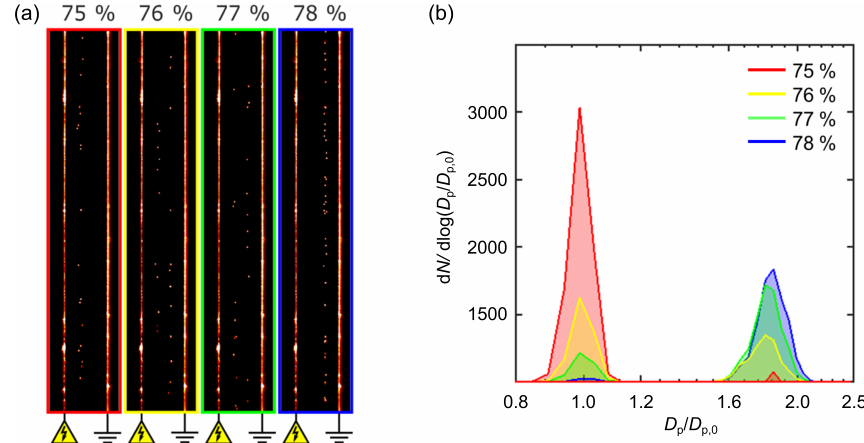
Figure 6. (a) Camera images showing particle positions and (b) growth factor distributions of NaCl particles ( D p , 0 = 50nm) measured around the deliquescence point. Red, yellow, green and blue distributions correspond to 75, 76, 77 and 78% RH, respectively.